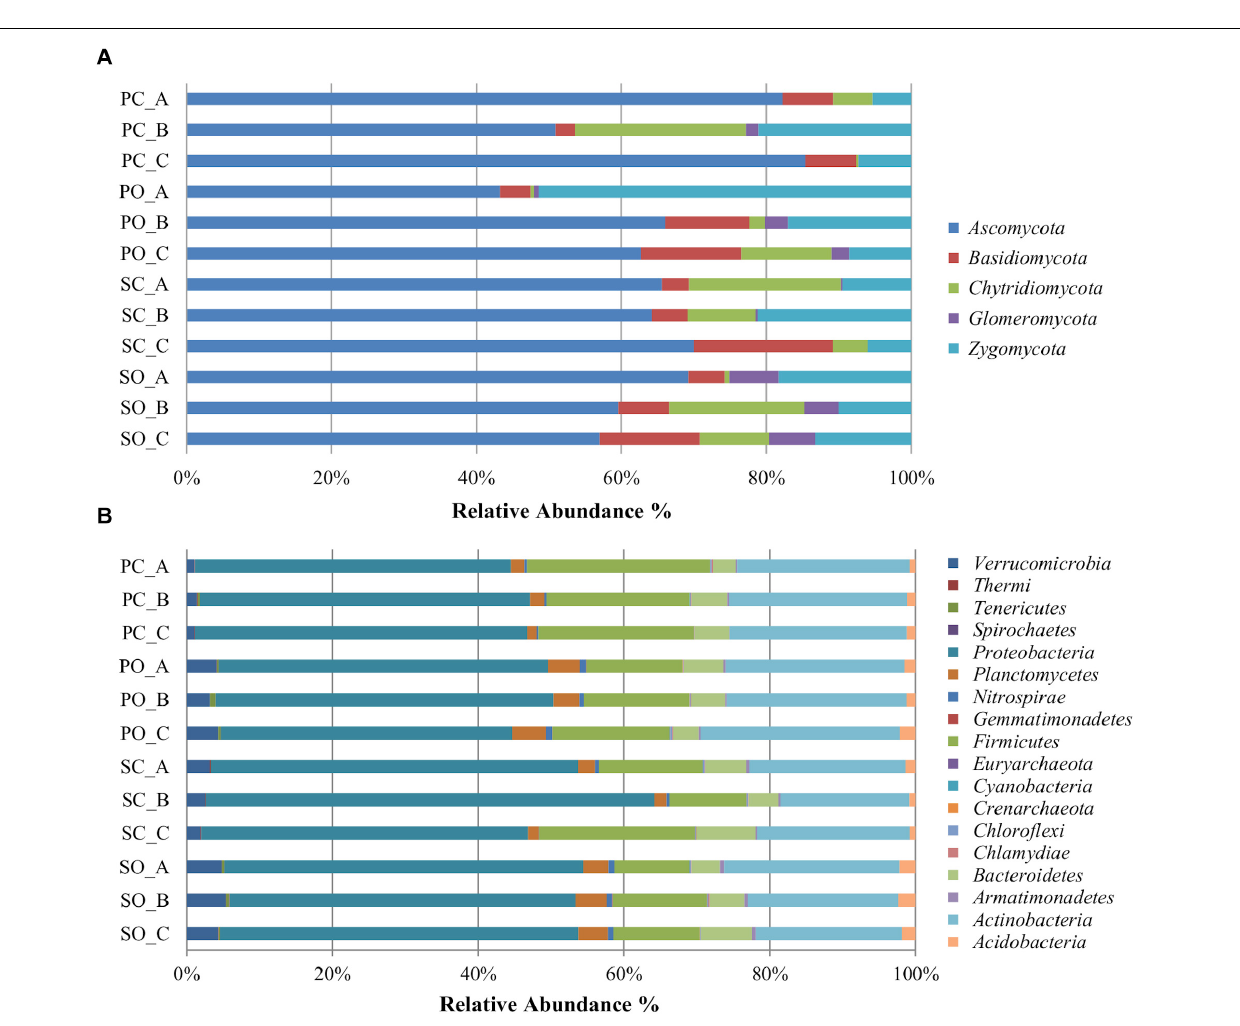
FIGURE 1 | Relative abundance of different fungal (A) and bacterial (B) phyla in the soil rhizosphere in both populations. PC_A , “Pigarro” conventional plant A; PC_B , “Pigarro” conventional plant B; PC_C , “Pigarro” conventional plant C; PO_A , “Pigarro” organic plant A; PO_B , “Pigarro” organic plant B; PO_C , “Pigarro” organic plant C; SC_A , “SinPre” conventional plant A; SC_B , “SinPre” conventional plant B; SC_C , “SinPre” conventional plant C; SO_A , “SinPre” organic plant A; SO_B , “SinPre” organic plant B; SO_C , “SinPre” organic plant